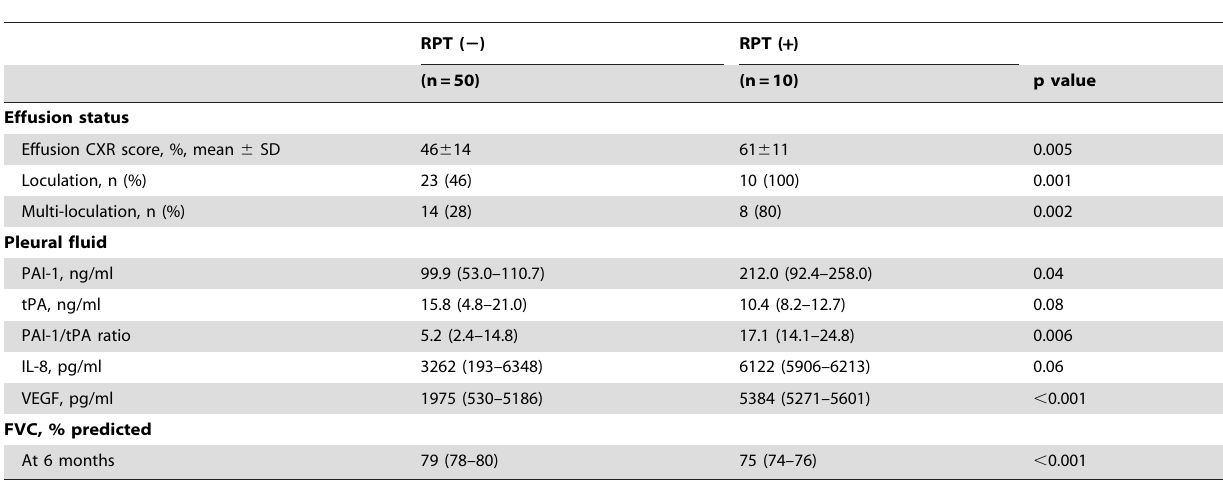
Table 7. Pleural Fluid Variables and Pulmonary Function in Patients With or Without Development of Residual Pleural Thickening